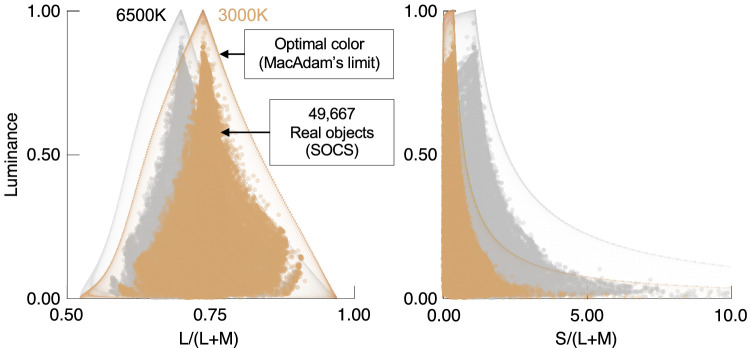
Color distribution of 102,721 optimal colors and 49,667 real objects in the SOCS database. They are rendered under 6500 K (gray distribution) and 3000 K (orange distributions) to show the effect of illuminant change. The left and right panels show L/(L+M) versus. luminance and S/(L+M) versus luminance distributions, respectively.